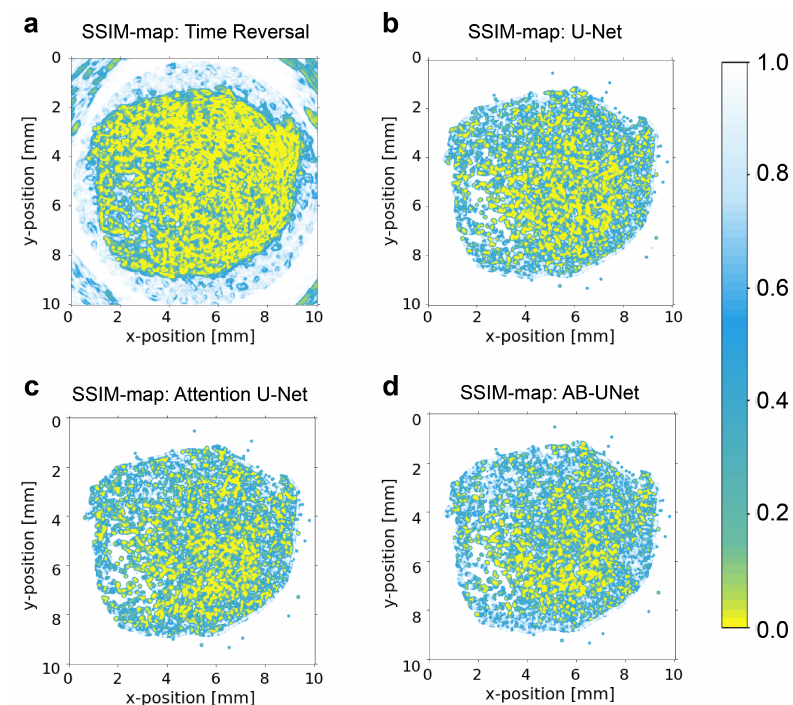
Figure 6. Comparison of structural similarity (SSIM) map based on different CNN architectures: ( a ) Time Reversal, ( b ) U-Net, ( c ) Attention U-Net and ( d ) AB-U-Net. Yellow corresponds to reconstructed areas with low SSIM, which indicates the poor reconstruction performance.